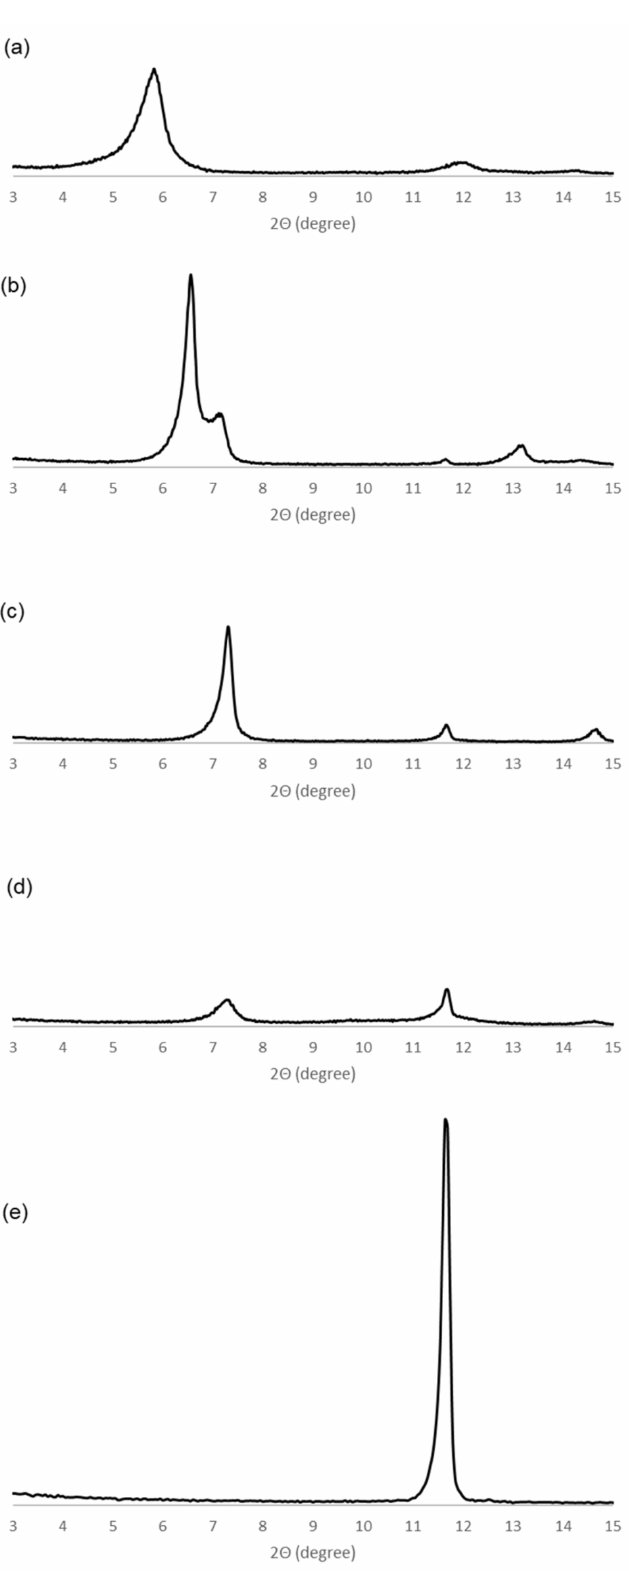
Figure 1. XRD patterns for ( a ) α -ZrP · 0.58DBU, ( b ) α -ZrP · 0.44DBU, ( c ) α -ZrP · 0.22DBU, ( d ) α - ZrP · 0.10DBU, and ( e ) pristine α